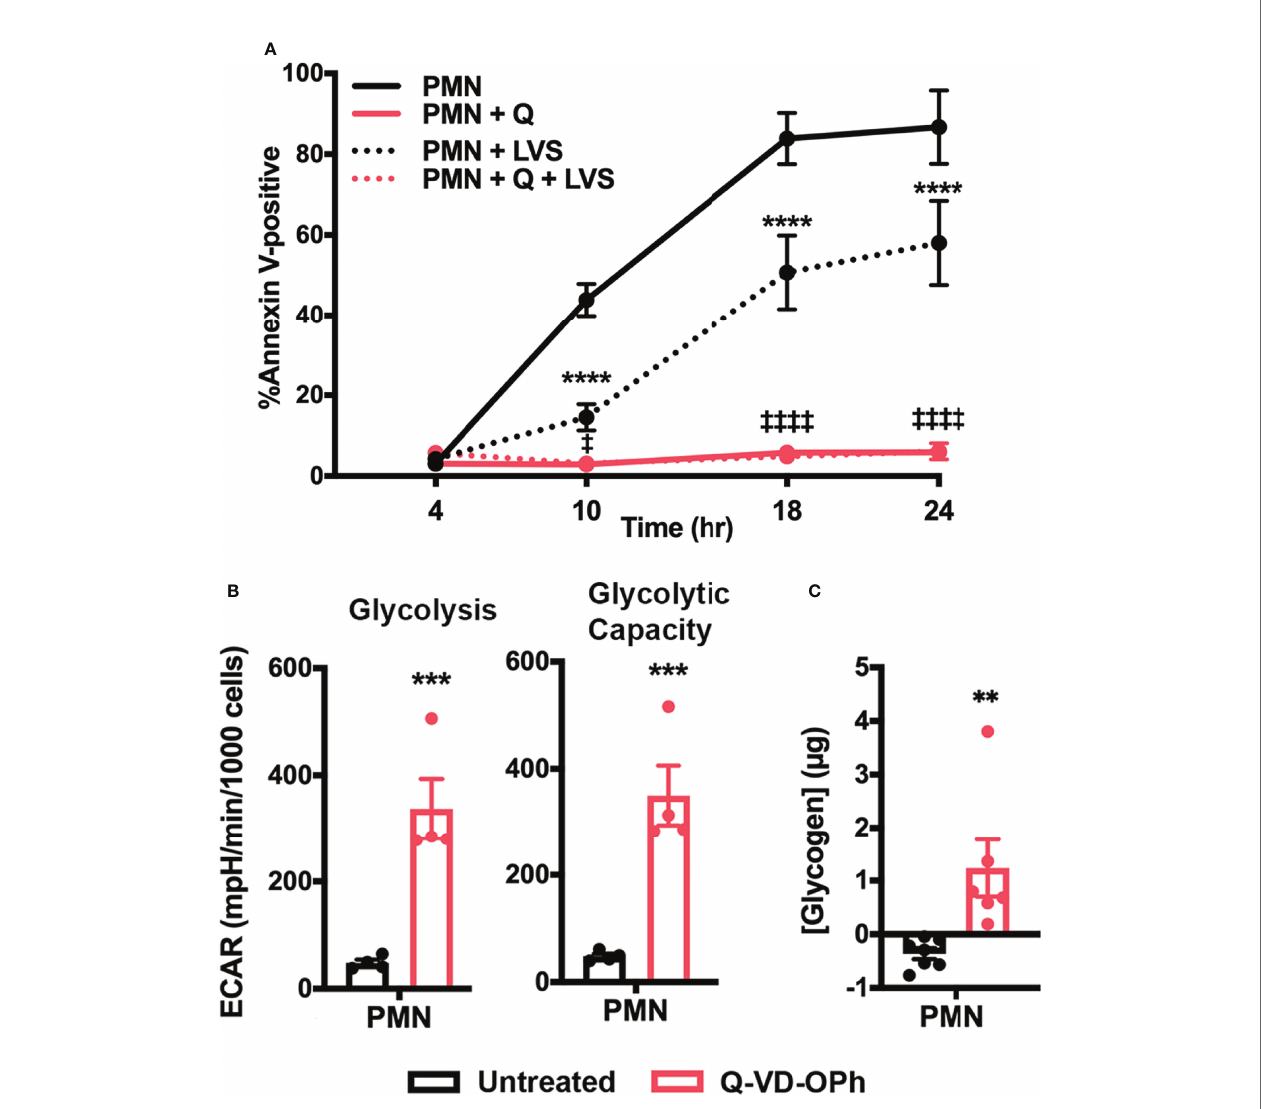
FIGURE 9 | Caspase inhibition increases PMN glycolysis, glycolytic capacity, and glycogen abundance. (A) Kinetics of apoptosis of control and Q-VD-OPh-treated PMNs were measured using Annexin V-FITC staining and fl ow cytometry. Data are the mean ± SEM, n=3. **** p < 0.0001 compared to untreated, uninfected PMNs, ‡ p < 0.05 and ‡‡‡‡ p < 0.0001 compared to untreated, LVS-infected PMNs at the indicated time points. (B) Quantitation of glycolysis and glycolytic capacity measured by Seahorse analysis as extracellular acidi fi cation rate (ECAR) in PMNs in the presence or absence of Q-VD-OPh at 12 hr, n=4. *** p < 0.001. (C) Measurement of glycogen abundance in PMNs in the presence or absence of Q-VD-OPh at 24 hr, n=6-7. ** p <